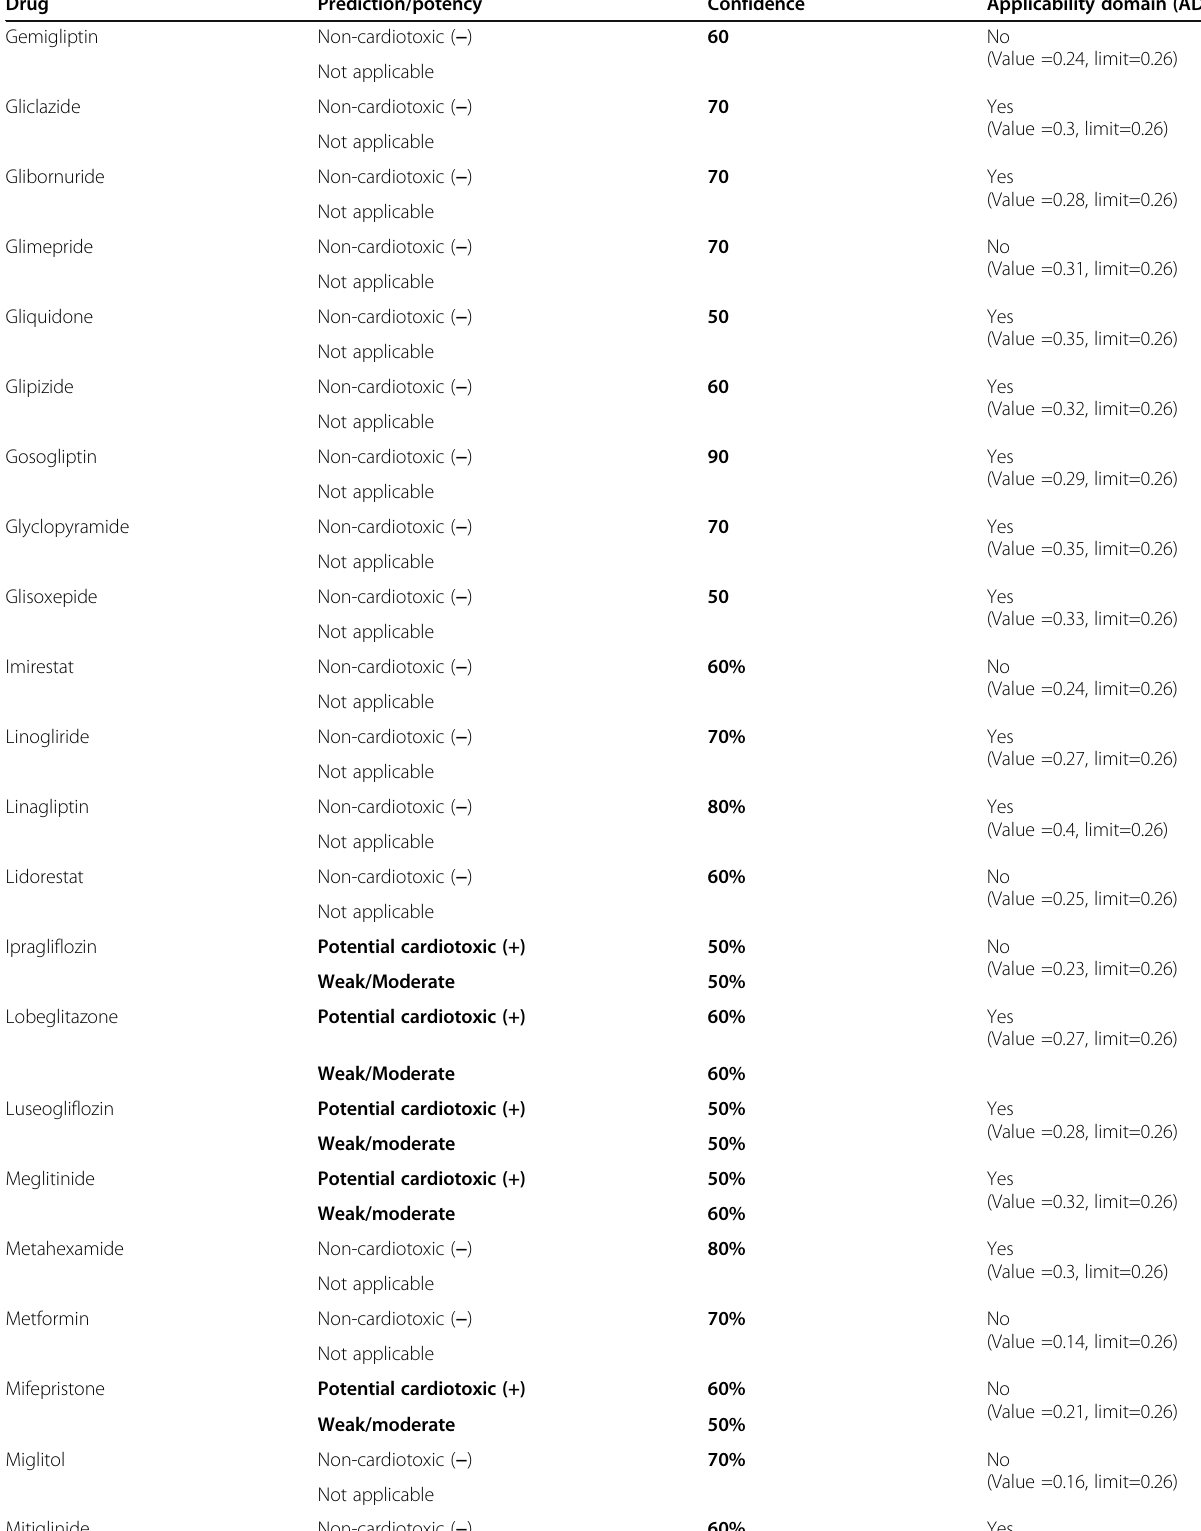
Table 1 Details of anti-diabetic compounds selected for study and their hERG blocking profile (Continued)